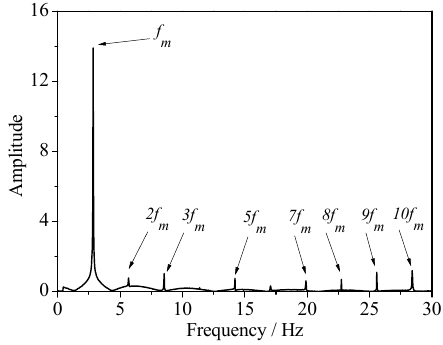
Figure 5. Radial vibration frequency spectrum of planetary gear bearing.